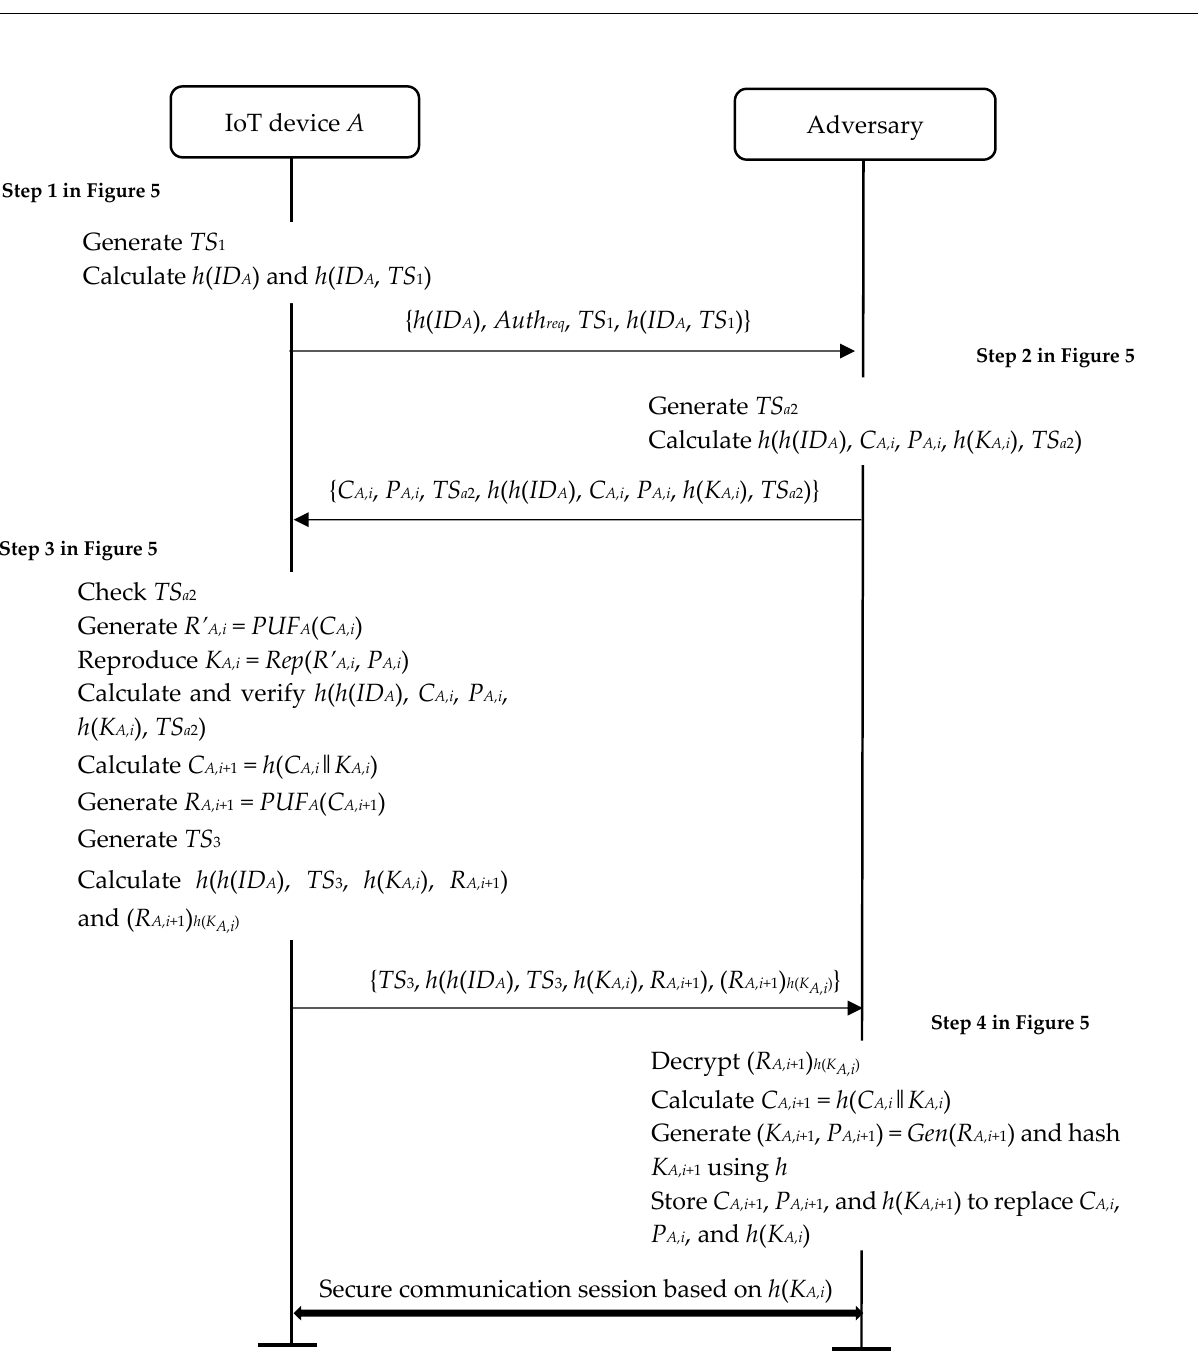
Figure 6. Impersonating server attack.